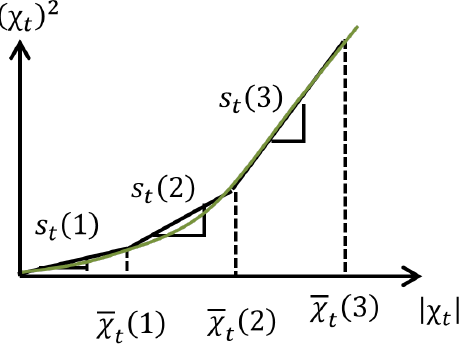
Figure 2. Piecewise linearization of a quadratic